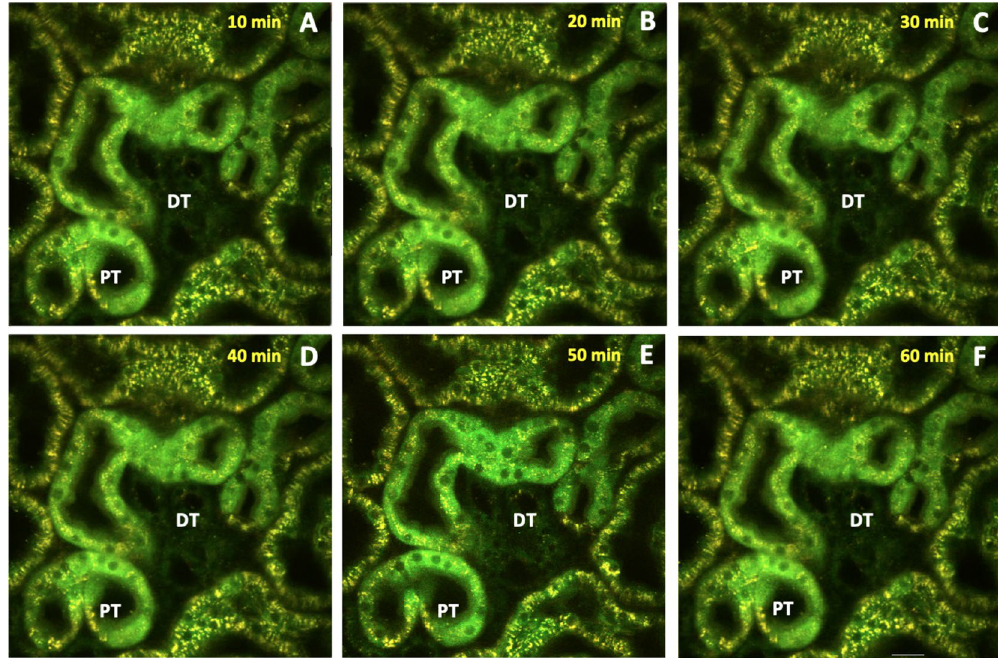
Figure 3. Intravital two-photon micrographs were taken with a ×60 objective from a live rat that received HGD. All images were formed by merging the green-and red-pseudo-color channels and shows the homogenous distribution of EGFP-actin expression in both proximal and distal tubules that did not appear to be affected by continuous imaging over a 1-h period. Scale bar represents 20